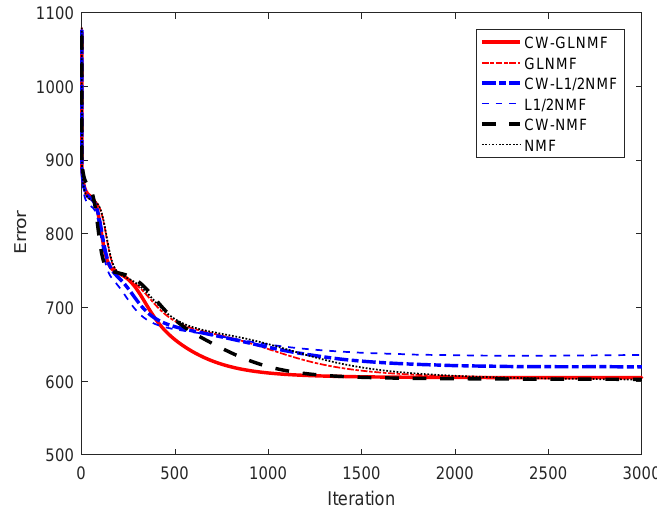
Figure 5. The convergence comparison of our proposed methods and other methods.